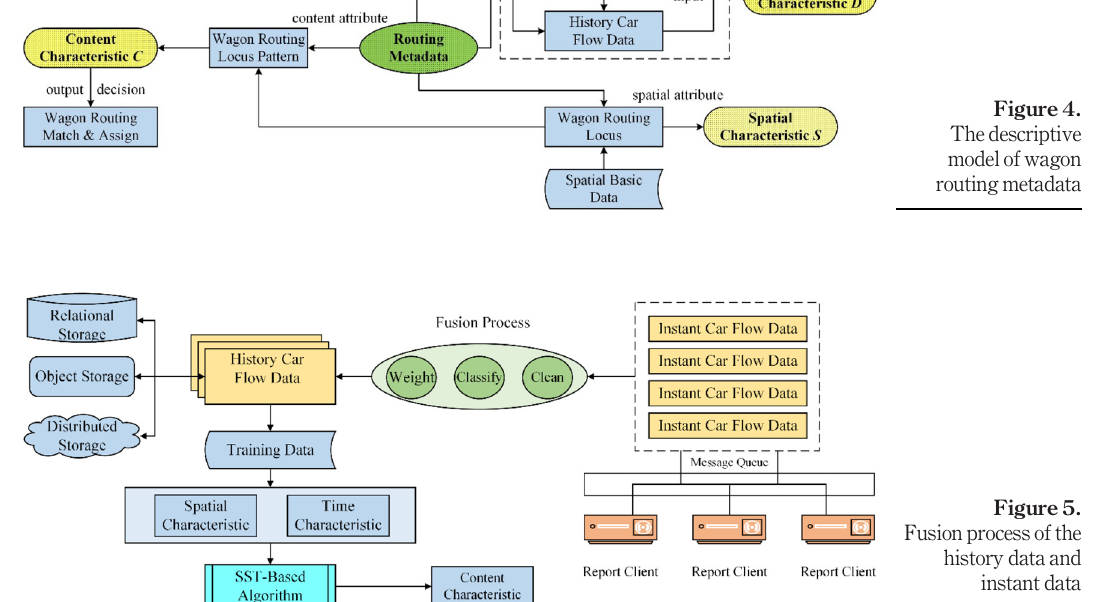
Figure 5. Fusion process of